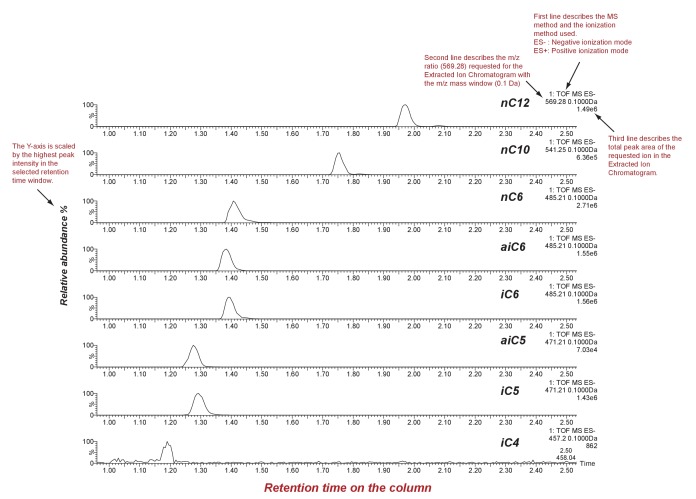
SsASAT1 reactions with different acyl CoA substrates.Shown are extracted ion chromatograms of SsASAT1 reactions using sucrose as the substrate and various acyl CoAs as donors. No product was found with acetyl CoA as donor. LC/MS analyses were conducted using a C18 column in the negative ionization mode as described in the Methods. Descriptions of different parts of the chromatogram that aid in understanding the chromatogram are highlighted in red.